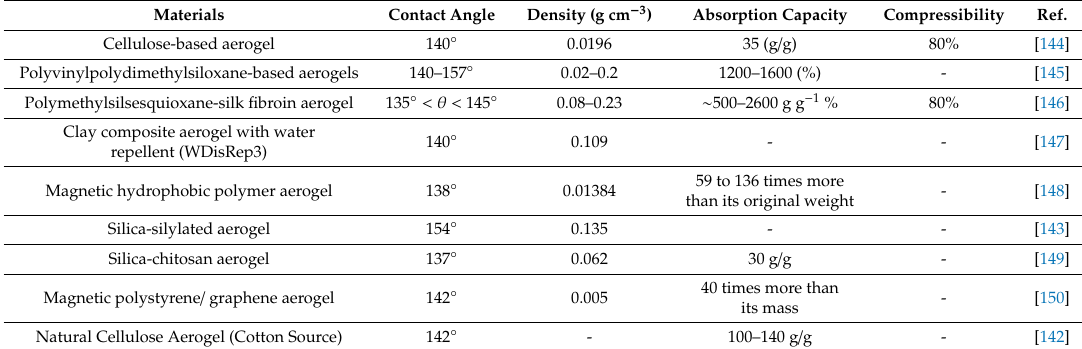
Table 1. Comparison of hydrophobic composite